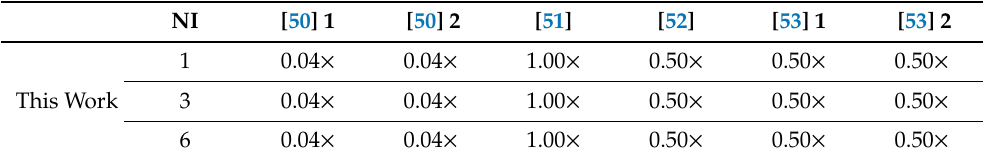
Table 17. Analysis of the ratio occupation for